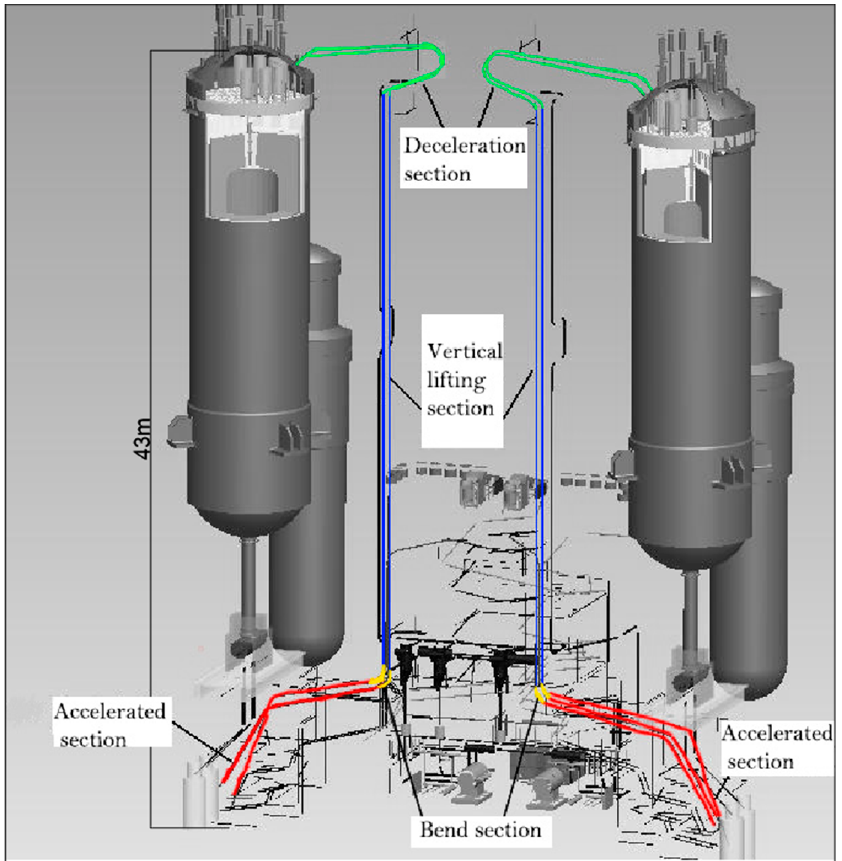
Figure 6. Fuel ‐ element pneumatic lifting system. Figure 6. Fuel-element pneumatic lifting